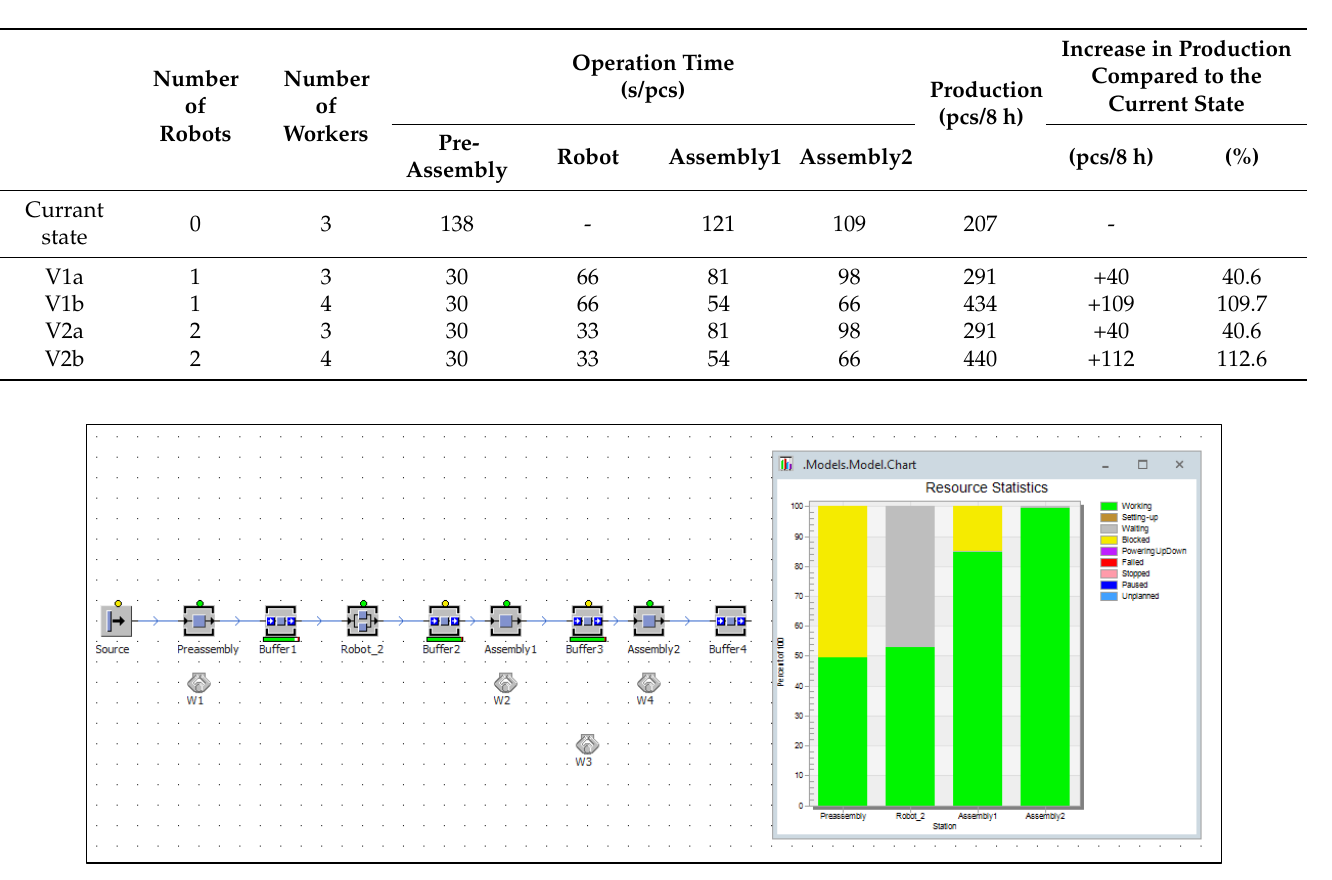
Figure 7. Variant 2b (two robots, four people).